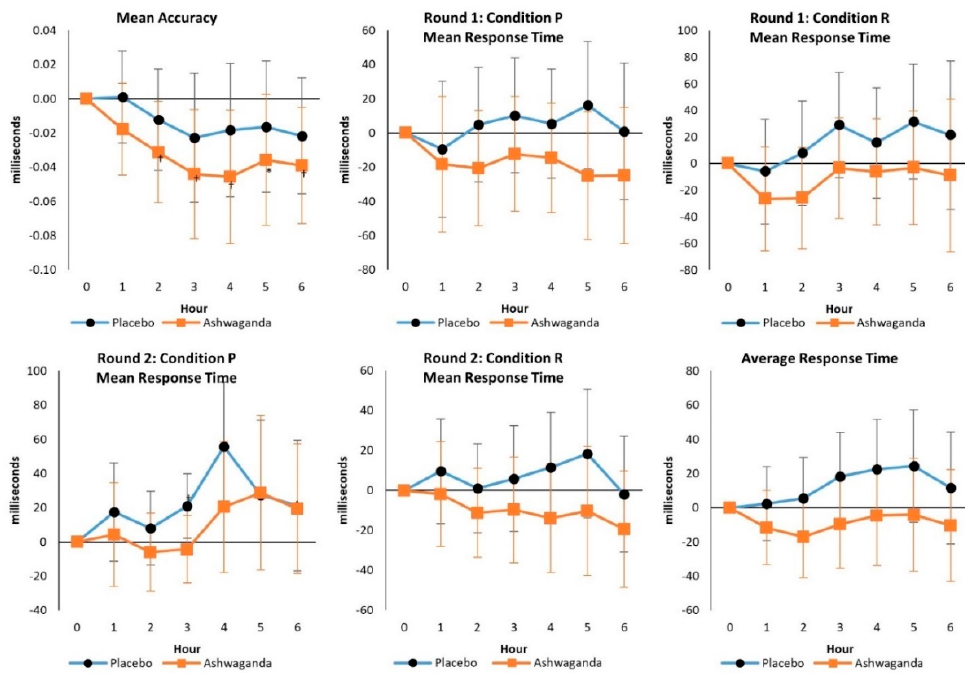
Figure 4. Go/No-Go test responses. Data are mean differences from baseline with 95% confidence intervals. † indicates p < 0.05 difference from baseline values. * indicates p > 0.05 to p < 0.10 difference between treatments.